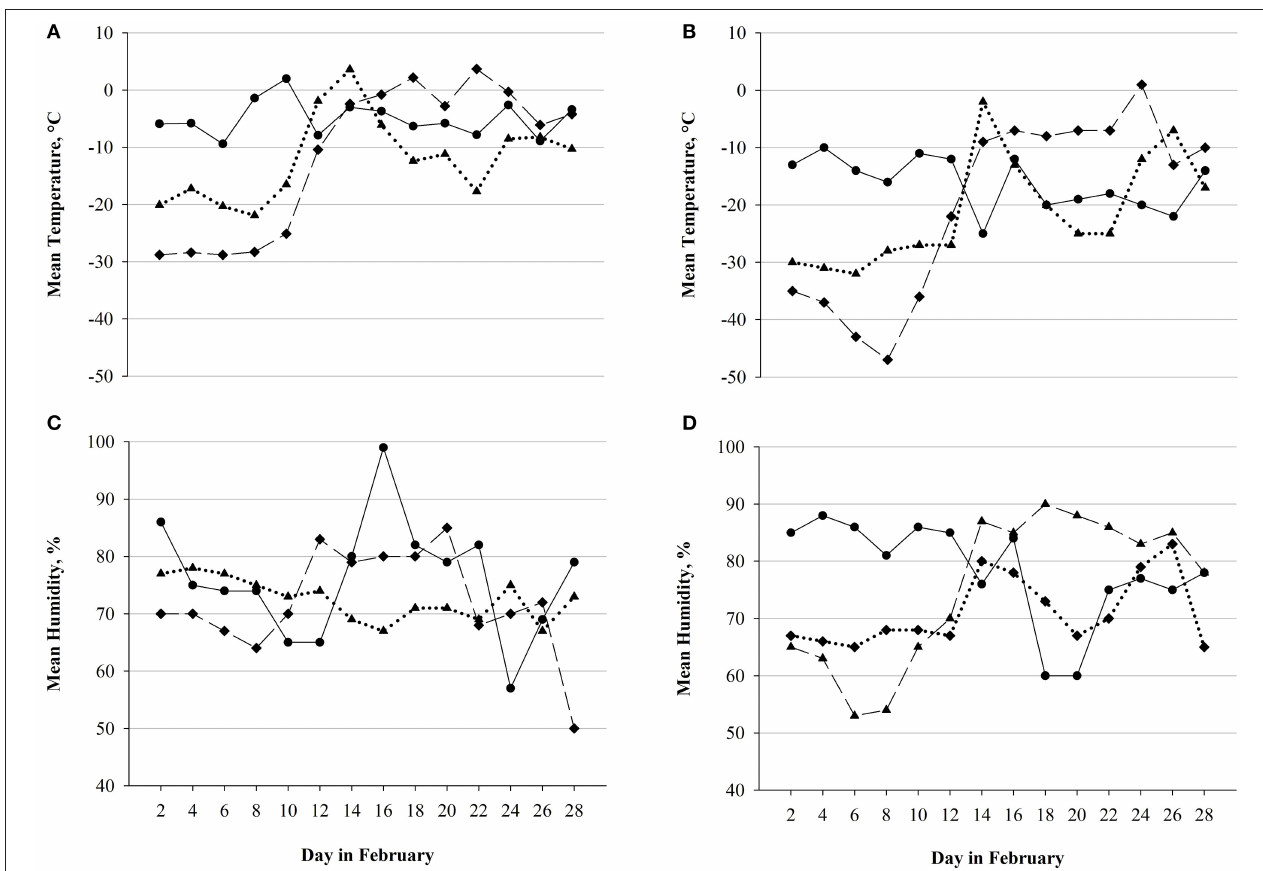
FIGURE 1 | Weather conditions across editions. Mean temperature and mean humidity as measured in Whitehorse and Dawson City in February 2013 (solid line), February 2015 (long dashed line), and February 2017 (dotted line). (A) Mean temperature in Whitehorse. (B) Mean temperature in Dawson City. (C) Mean humidity in Whitehorse. (D) Mean humidity in Dawson City. No significant differences between editions or locations 4